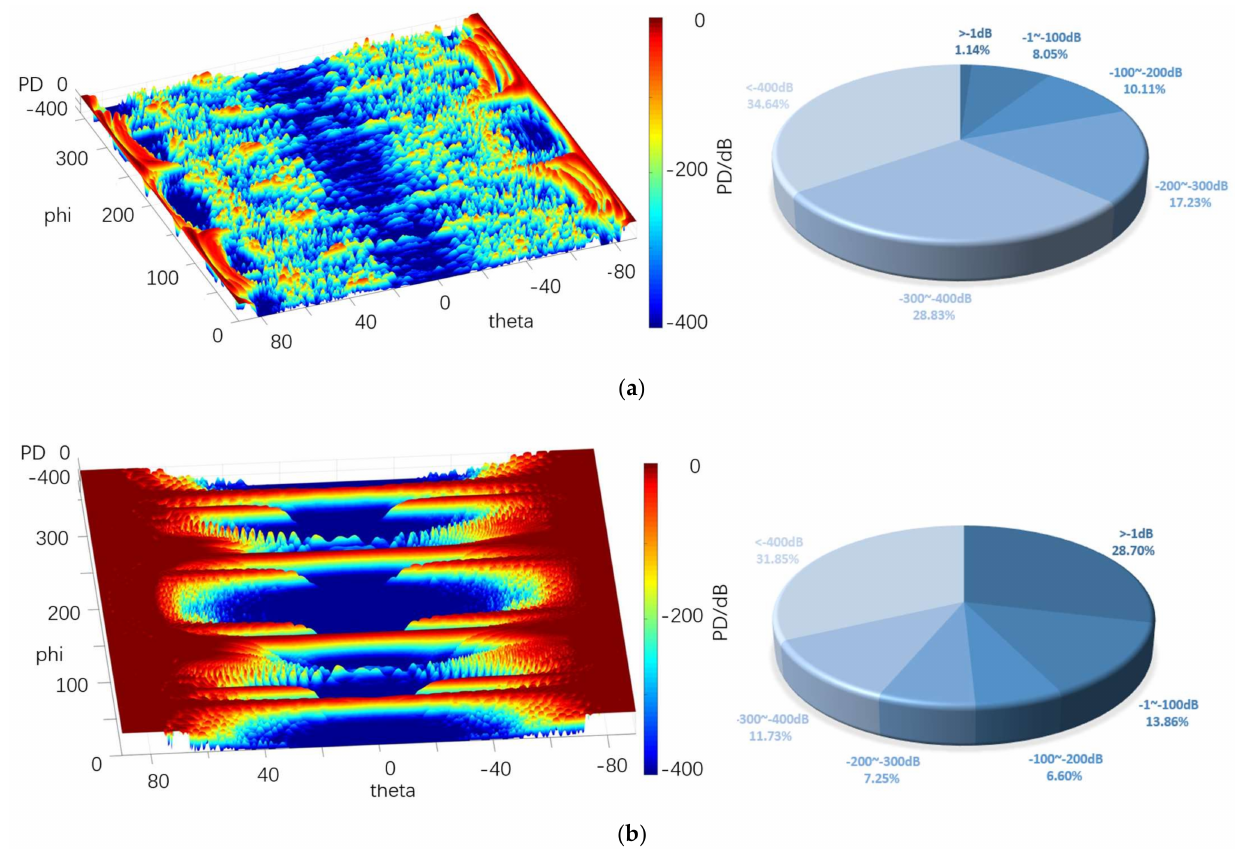
Figure 22. Probability distribution in the 4 π direction for 1800 km. ( a ) Quantum detection probability, ( b ) Probability of conventional